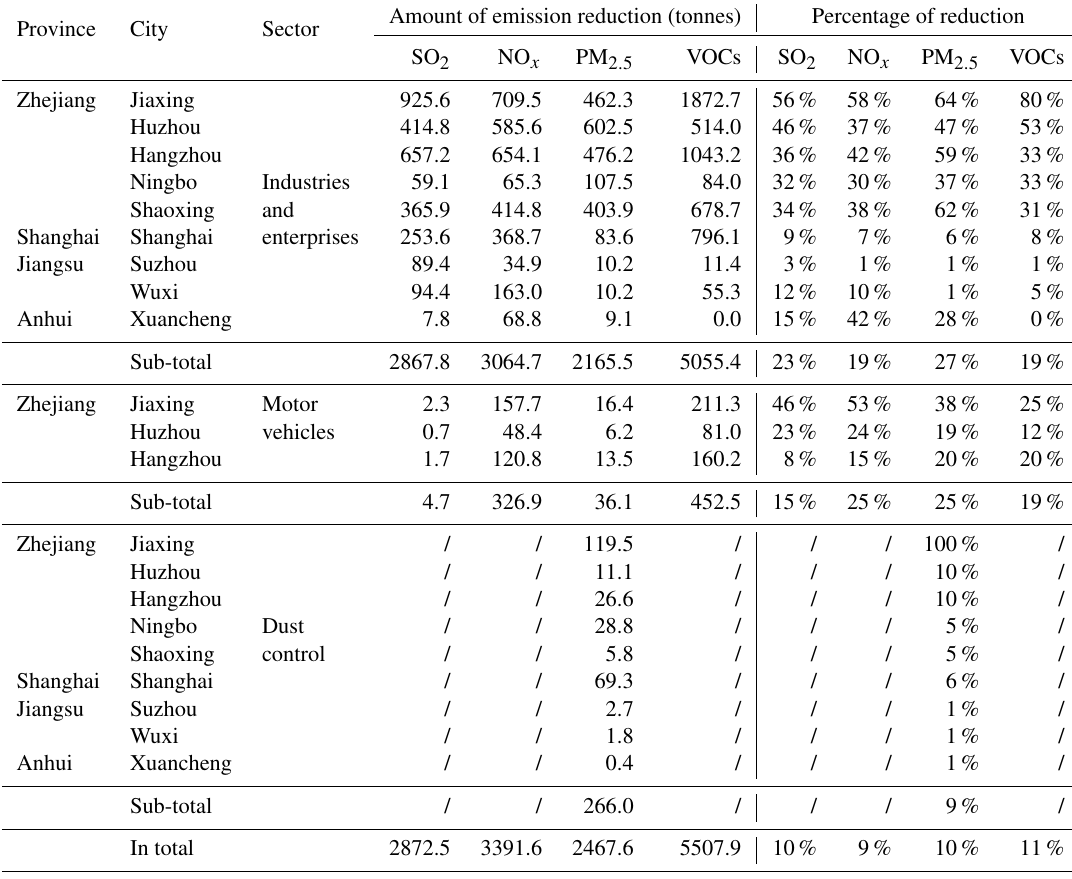
Table 4. Emission reduction estimations for various control measures.